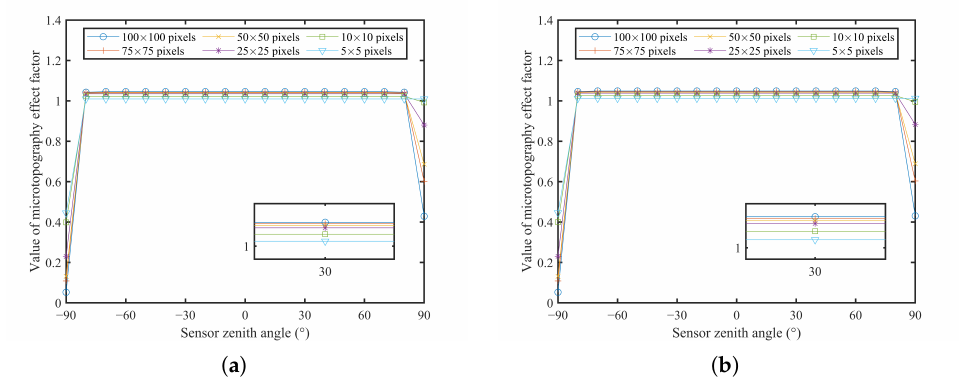
Figure 4. MRRT model. Variation of the microtopography effect factor under various illumination observations of the solar location’s primary plane: ( a ) (0 ◦ , 150 ◦ ) and ( b ) (45 ◦ , 150 ◦ ). MRRT: multiple reflections of radiation between